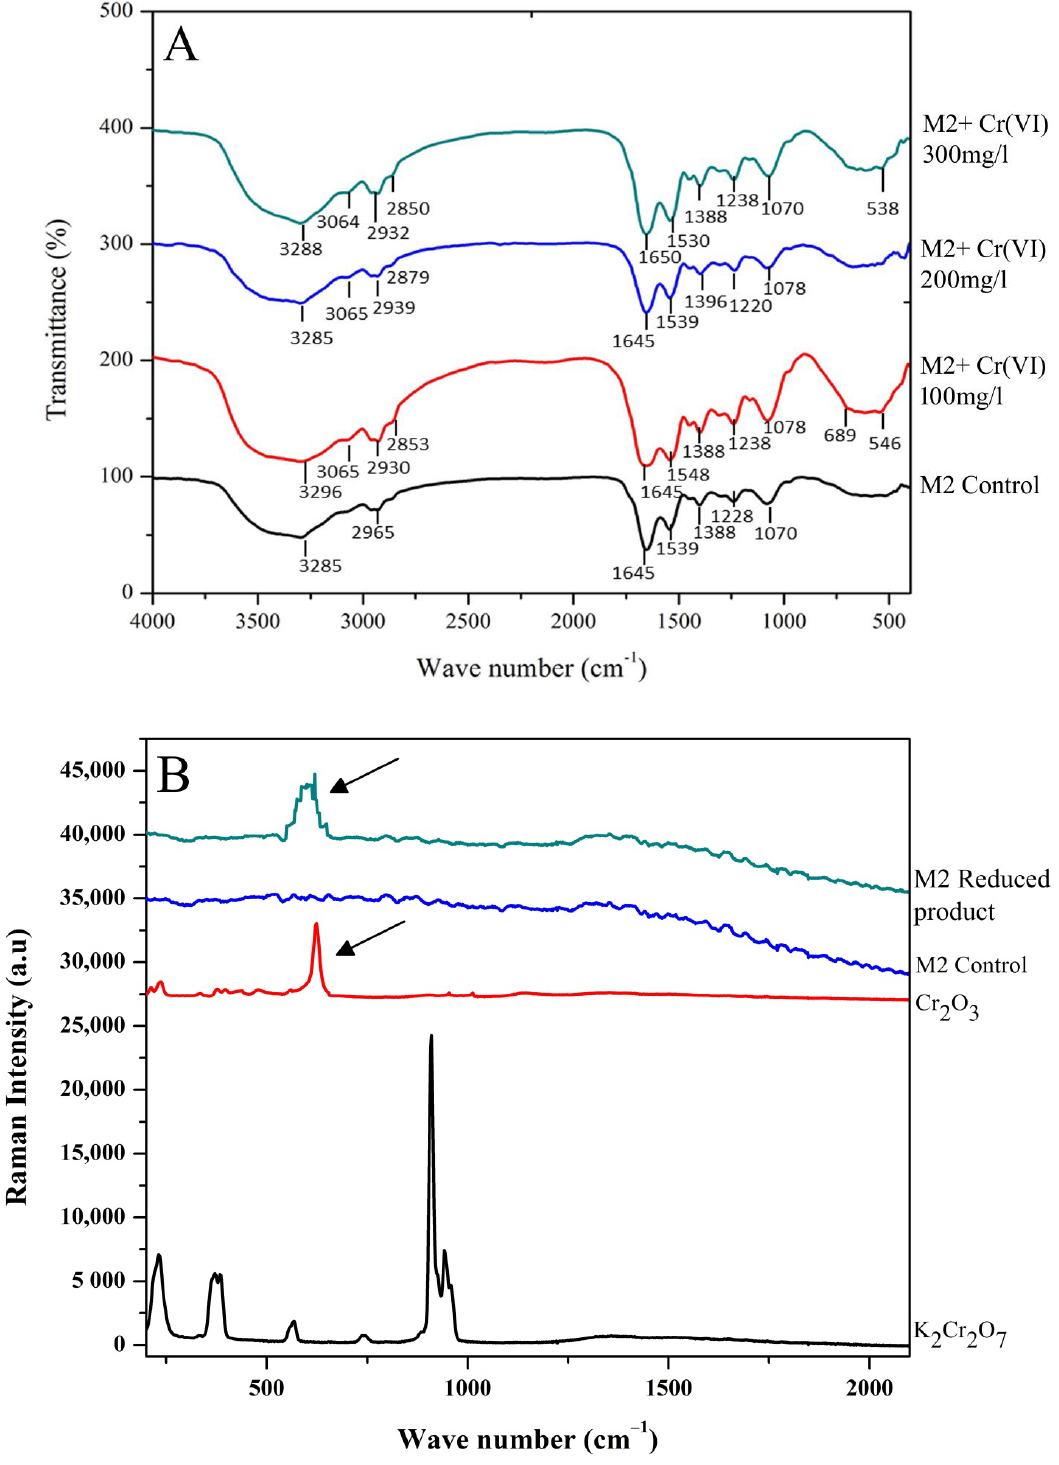
Figure 3. ( A ) FTIR spectra of the rhizobacterial strain M2 treated with and without Cr(VI); ( B ) Raman spectra of Cr(VI) (K 2 Cr 2 O 7 ), Cr(III) (Cr 2 O 3 ) and reduced product associated with the rhizobacterial strain M2. [Black arrows indicate the reduced product of M2 with Cr(III)